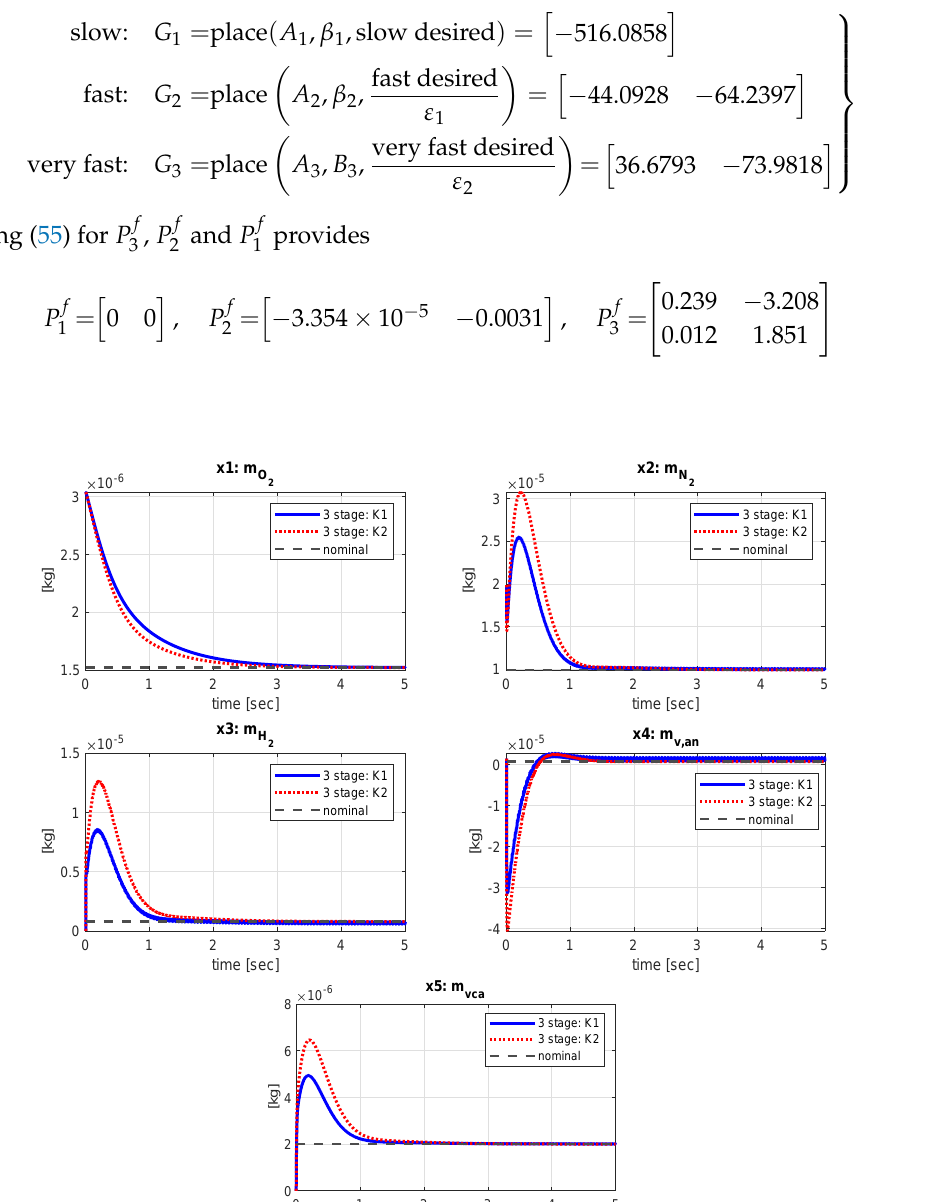
Figure 13. System response (states) comparison: Three stage controller K 1 design and Three stage controller K 2 design for linearized model state space matrices given in Appendix A. For illustration purposes, model is simulated from non-nominal initial conditions and it can be observed that different setting of the desired poles of the controllers K 1 and K 2 , lead to different time responses. For final tuning and actual application on the real system, more detailed analysis is needed for fulfillment of the design requirements such as settling time, overshoot etc., of each state